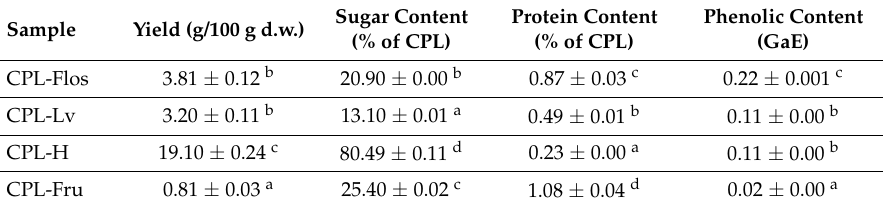
Table 2. The yield of R. rugosa crude polysaccharides (g/100 g of dry weight) and their composition. Sugar and protein content is given in % of crude polysaccharide. Total phenolic content expressed as gallic acid equivalents per g of CPL (GaE). Abbreviations: CPL-Flos—crude polysaccharide from flowers; CPL-Lv—crude polysaccharide from leaves; CPL-H—crude polysaccharide from